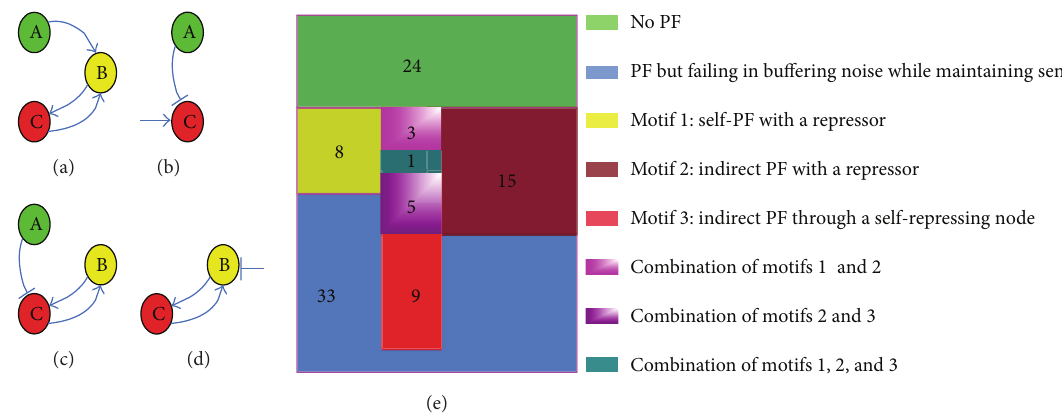
Figure 4: (a) A biological circuit that is not competent for buffering noise while maintaining sensitivity. (b) Motif 1: self-positive feedback with a repressor. (c) Motif 2: indirect positive feedback with a repressor. (d) Motif 3: indirect positive feedback though a self-repressing node. (e) Venn diagram of biological circuits with different characters. PF is short for positive